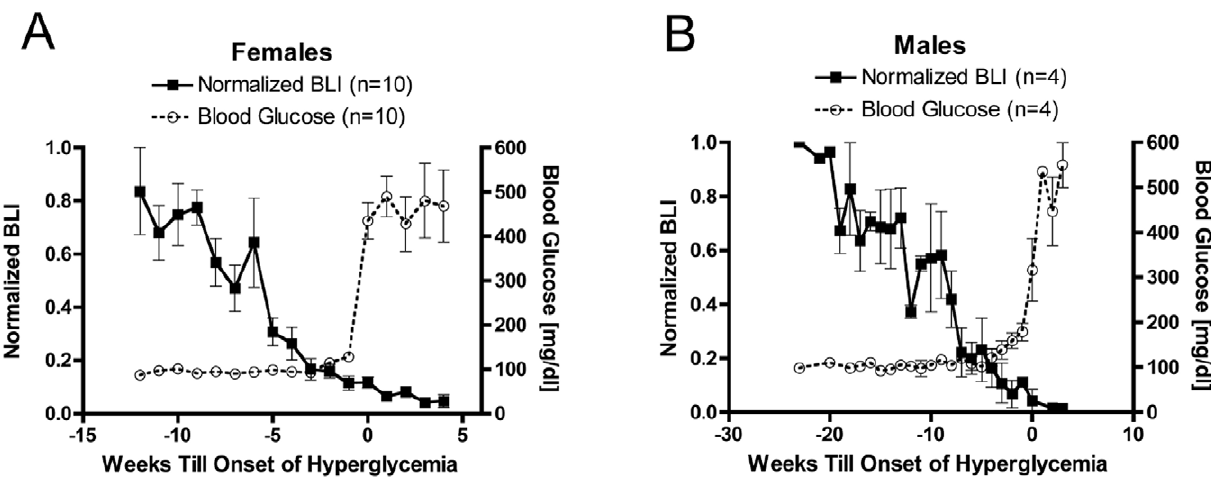
Figure 4. Decline in bioluminescence in MIP-Luc-VU-NOD mice precedes the onset of hyperglycemia. A) Female mice that become diabetic (blood glucose . 200 mg/dl) have a gradual reduction in BLI with increasing age that precedes hyperglycemia by four weeks. (P , 0.001 ANOVA and post-hoc test for linear trend, BLI and blood glucose). B) Male mice that become diabetic also display a reduction in BLI preceding hyperglycemia, with a slower decline in BLI and later onset of diabetes. (P , 0.001 ANOVA and post-hoc test for linear trend, BLI and blood